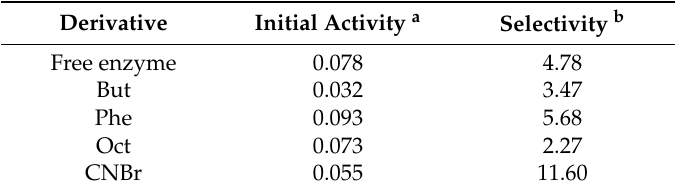
Table 4. Sardine oil hydrolysis by Penicillium sp. (CBMAI 1583) lipase